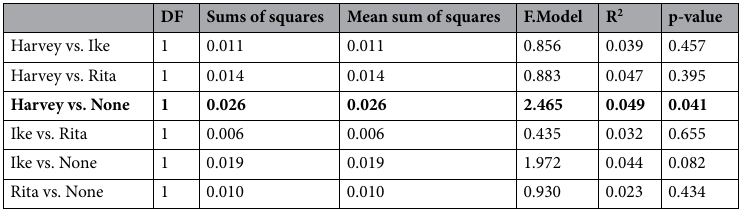
Table 1. Pairwise Permutational Multivariate Analysis of Variance (PERMANOVA) of natural log transformed mesozooplankton abundances. Grouping variables are based on presence of a major hurricane before sampling that year (Hurricane Rita, 2005; Hurricane Ike, 2008; Hurricane Harvey, 2017; non-storm years 2006, 2009, 2010, 2012, 2016). Bolded text indicates significance at α =